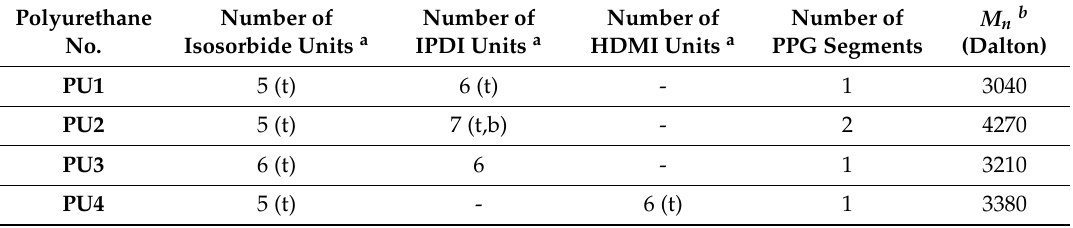
Table 5. The average compositions and M n of PU1 – PU4 determined by NMR spectroscopy.